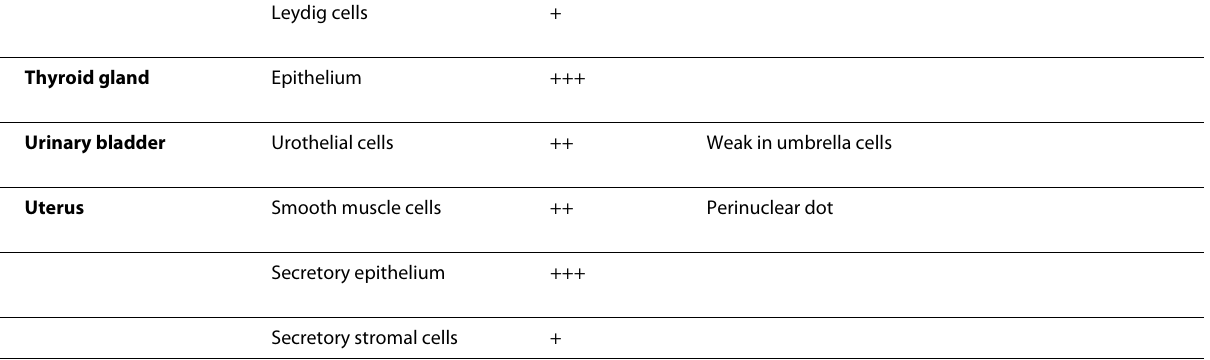
Table 1: Expression of FMNL2 in various tissues and cell types